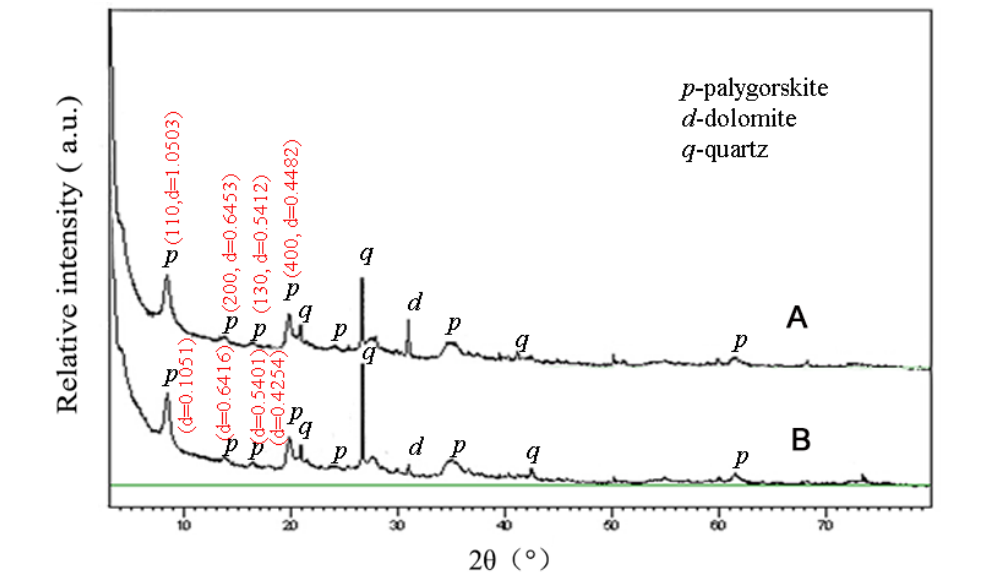
Figure 1. X-ray diffraction patterns of natural palygorskite (A) and zinc-bearing palygorskite (B). The raw palygorskite with the characteristic reflections appeared at 2 θ = 8.41° (110, d = 1.0503 nm), 2 θ = 13.72° (200, d = 0.6453 nm), 2 θ = 16.37° (130, d = 0.5412 nm), and 2 θ = 19.81° (400, d = 0.4482 nm), respectively. The heated palygorskite with the characteristic reflections appeared at 2 θ = 8.47° (110, d = 1.0434 nm), 2 θ = 13.71° (200, d = 0.6457 nm), 2 θ = 16.42° (130, d = 0.5398 nm), and 2 θ = 19.86° (400, d = 0.4470 nm), respectively. p = palygorskite, d = dolomite, q = quartz.